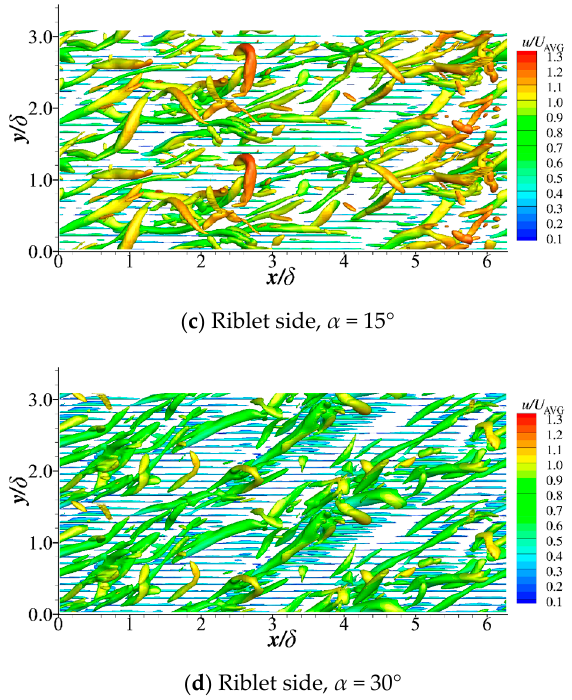
Figure 6. Iso-surface of the Q-criterion Q ( δ / U ∞ ) 2 = 1 (colored by the streamwise velocity).